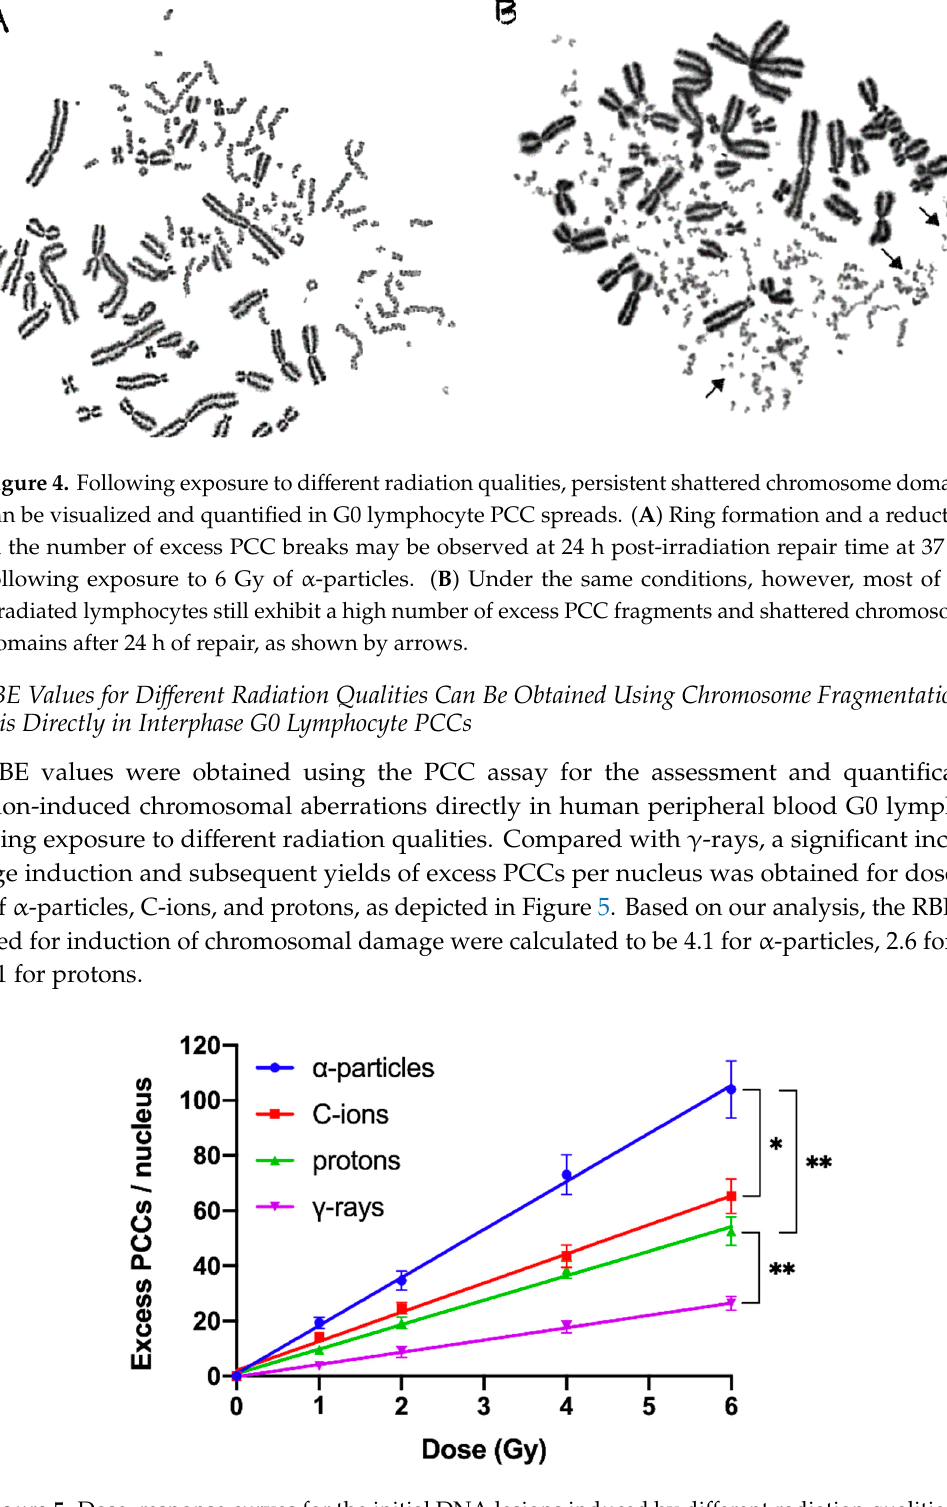
Figure 5. Dose–response curves for the initial DNA lesions induced by different radiation qualities as reflected in G0 lymphocyte PCCs and constructed by means of excess PCC fragments per nucleus at various doses up to 6 Gy of α -particles, C-ions, protons, and γ -rays. Based on this cytogenetic endpoint of initial induction of radiation damage, the relative biological effectiveness (RBE) values obtained were 4.1 for α -particles, 2.6 for C-ions, and 2.1 for protons. (Mean ± SD based on three independent experiments; n ≥ 50 cells analyzed per experimental point; * p ≤ 0.05, ** p ≤ 0.01).